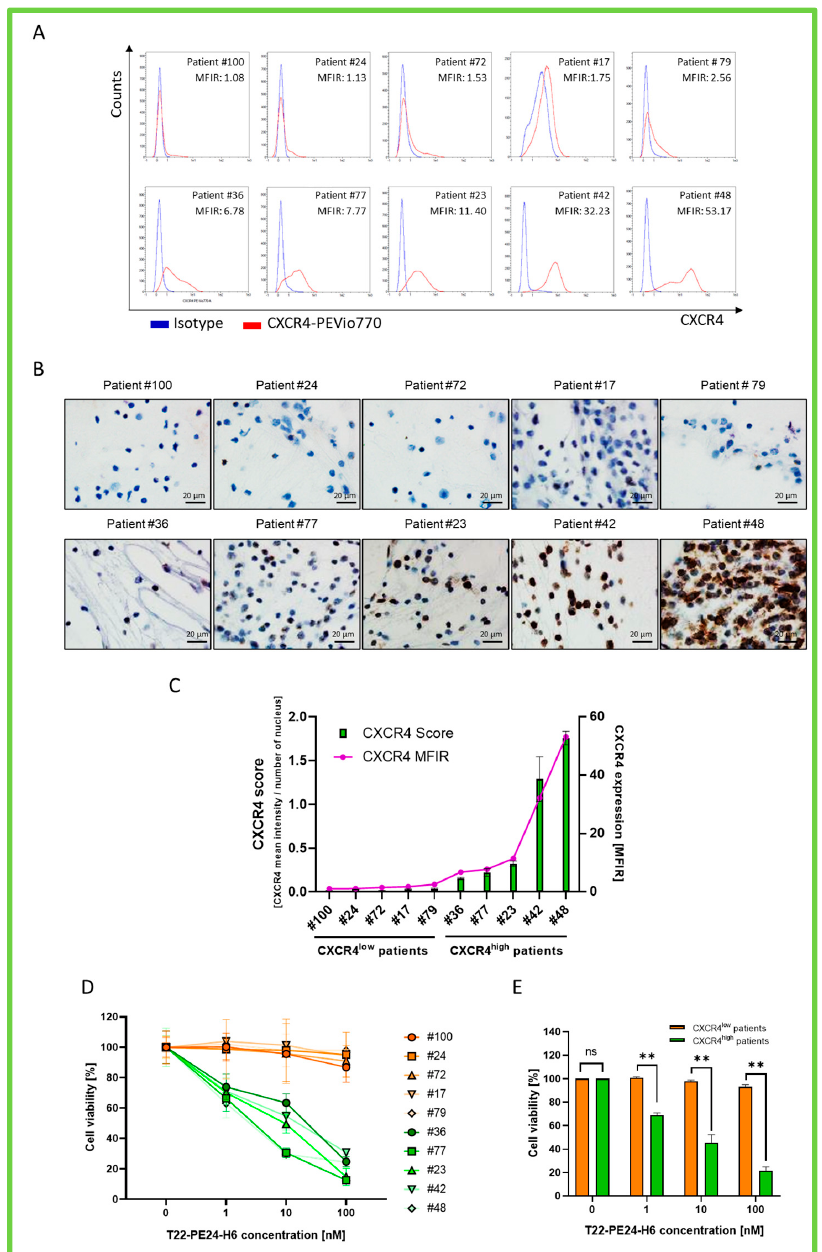
Figure 5. CXCR4 expression levels and T22-PE24-H6 in vitro anticancer effect in the BM AML patient samples. ( A ) Flow cytometric evaluation of CXCR4 surface expression in the BM samples using